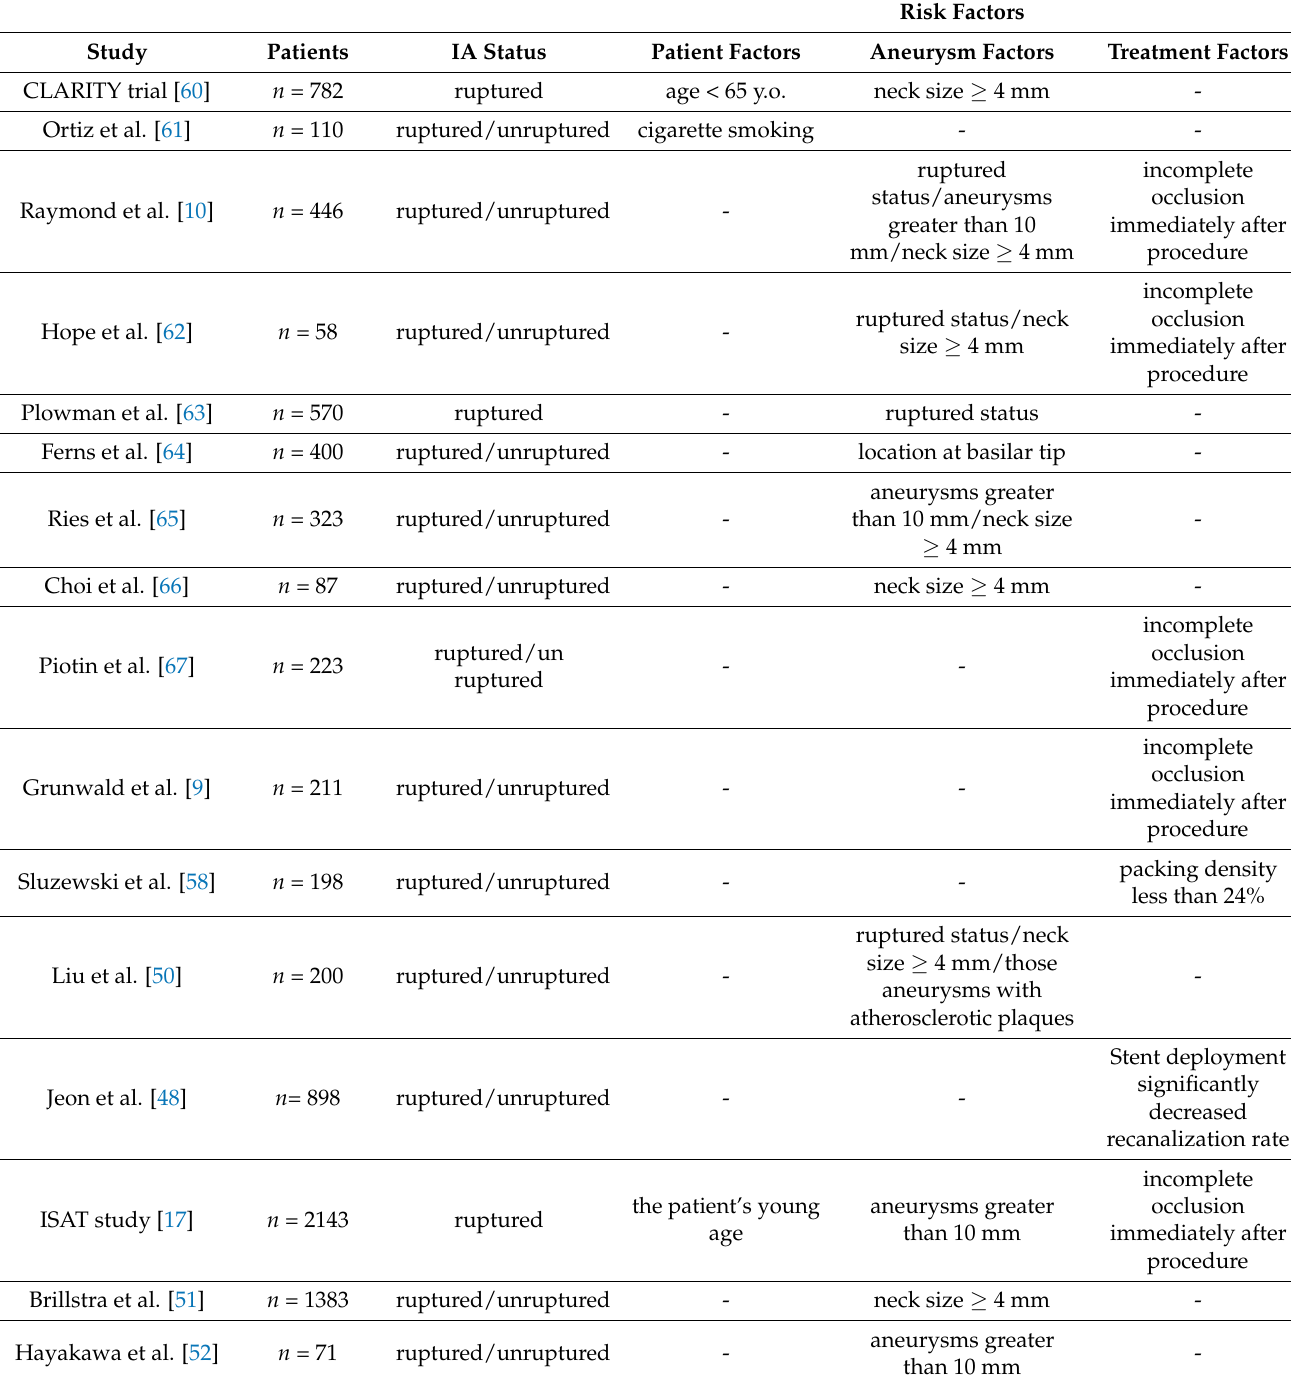
Table 7. Recanalization risk factors; literature